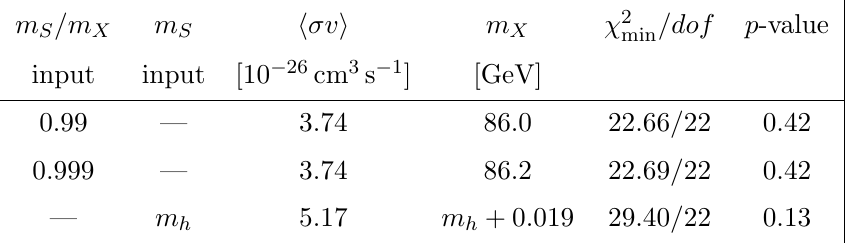
is given, and dof (cid:17) min